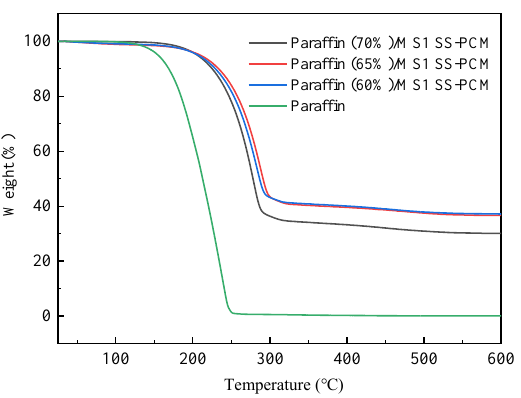
Figure 8. TGA curves of paraffin and paraffin/MS SS-PCMs containing MS with different pore diameters.